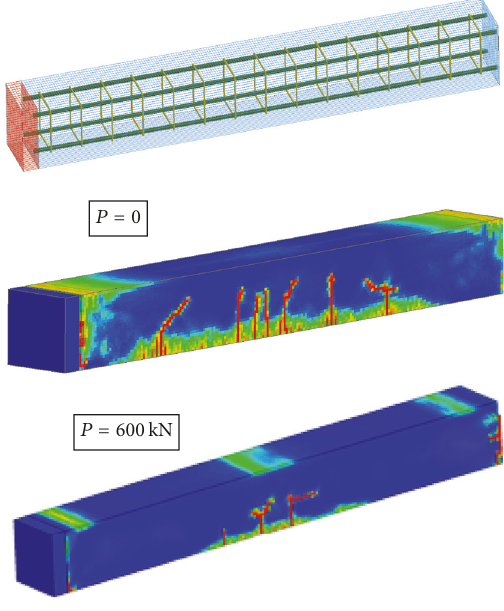
Figure 9: FE modeling and analysis of the